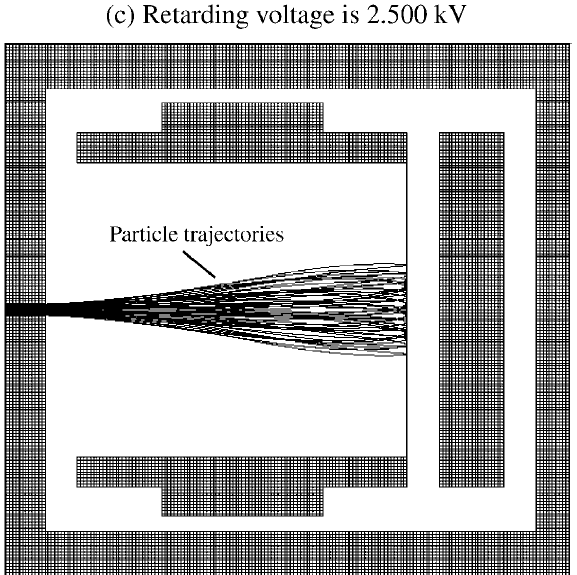
FIG. 3. Particle trajectories at different retarding